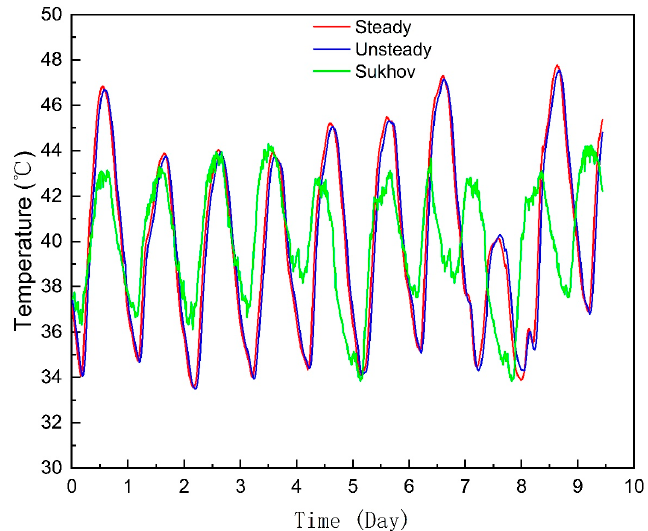
Figure 6. Temperature comparison.